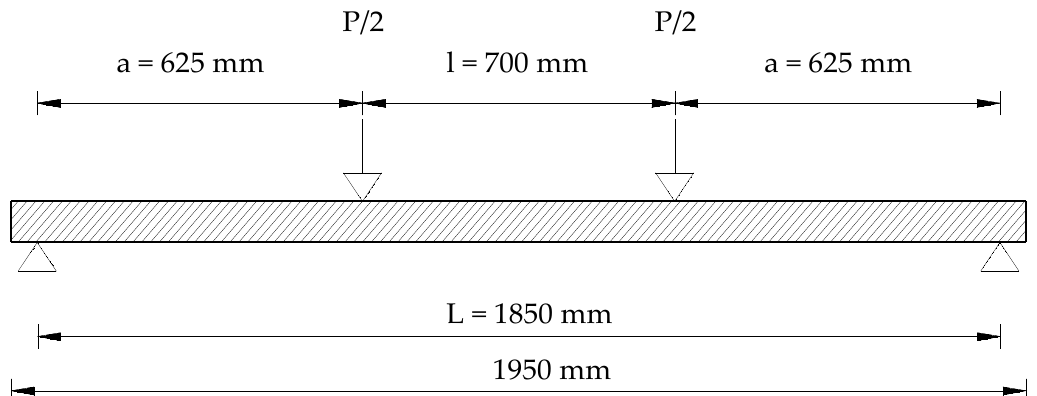
Figure 4. Schematic diagram of the four-point bending test field configuration for the specimens of